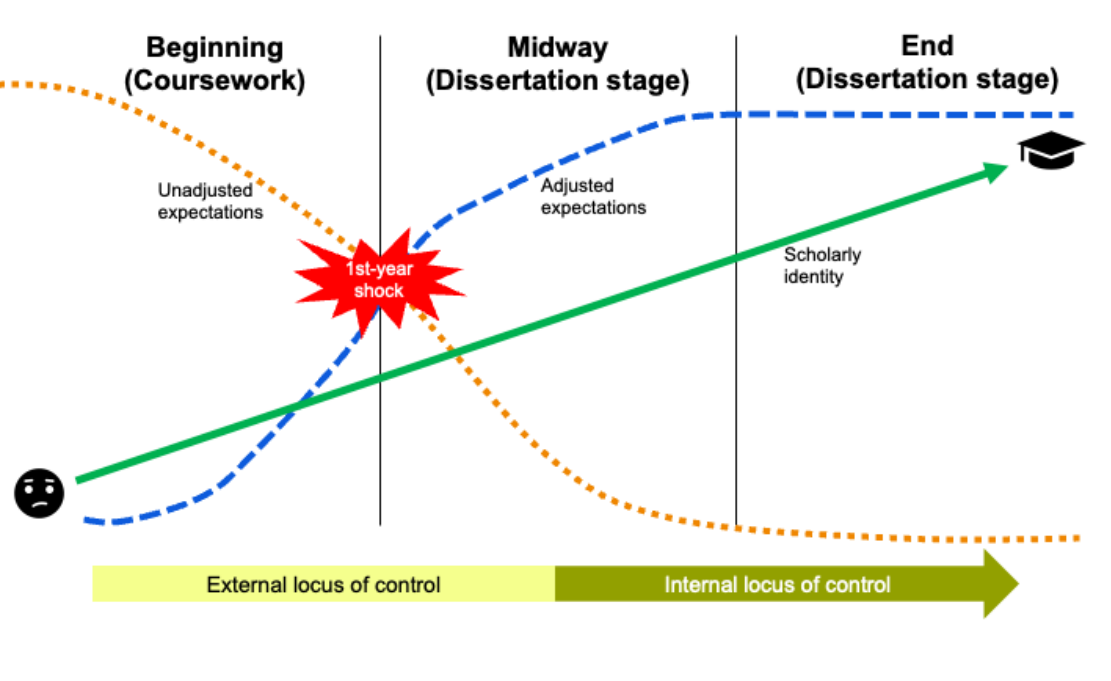
Observed Trends in the Online Doctoral